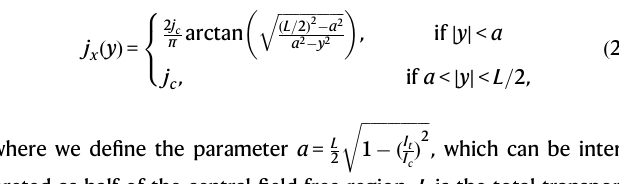
fi elds, asindicated. c – e Transverse ( H y ) magnetic fi eld orientation with μ the saturation fi eld in the + y direction ( c ), − y direction ( e ) and at the coercive fi eld ( d ). f – h Same values of magnetic fi eld but in an longitudinal orientation ( H x ). The signal range (in mT) for each individual image is noted above the color bar that